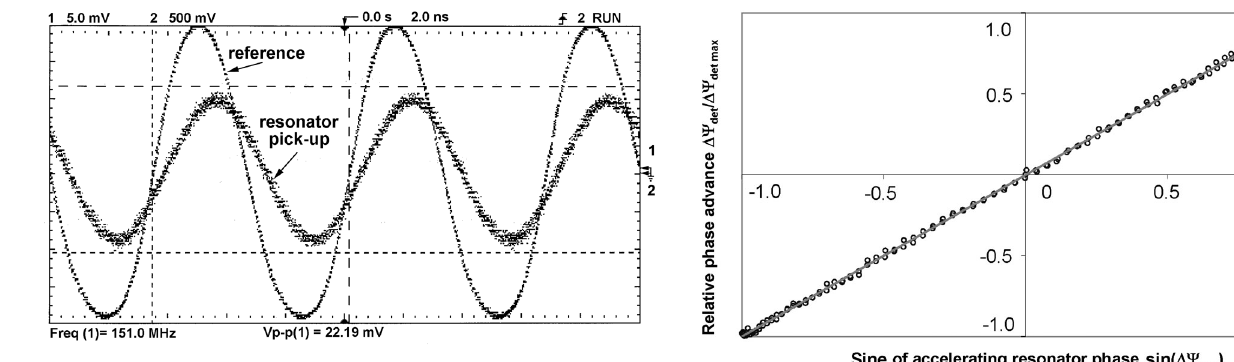
= Δ Ψ FIG. 8. Relative beam bunch phase Δ Ψ shown by det det max open circles as detected by the superconducting phase detector as a function of the cosine of the operating phase of the linac Þ . The straight solid line is the accelerating resonator cos ð Δ Ψ acc theoretical prediction of the same relationship. The energy of 58 Ni þ 22 beam produced by terminal and linac stripper is 185 MeV and beam current is 7 nA. The last (12th) linac resonator is configured as the phase